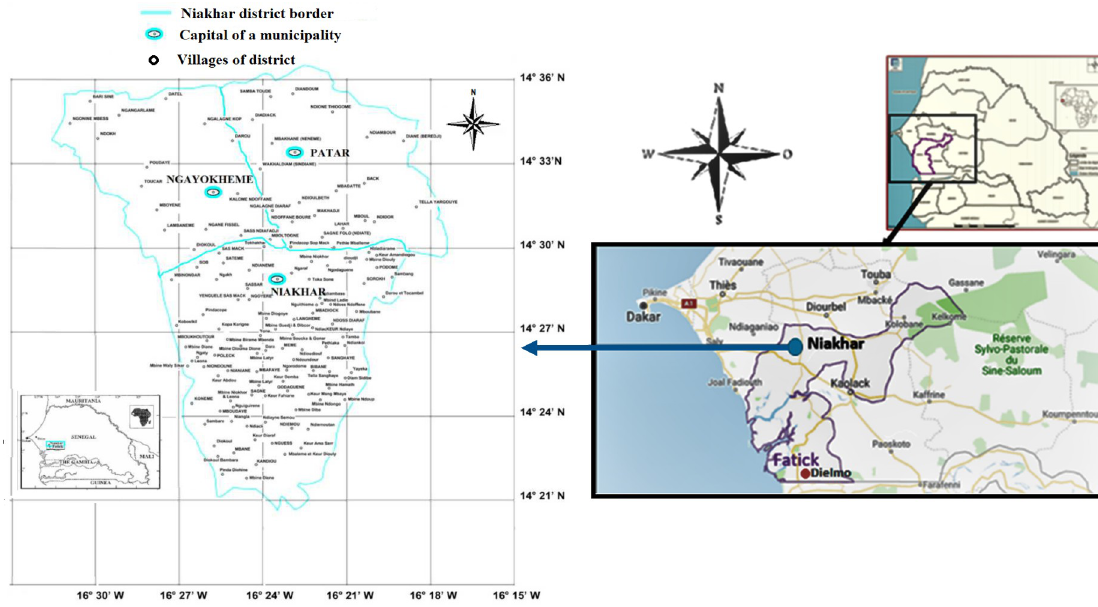
Fig 1. Location of the Niakhar district in the Fatick region of Senegal (source VITROME, IRD Dakar, Senegal).